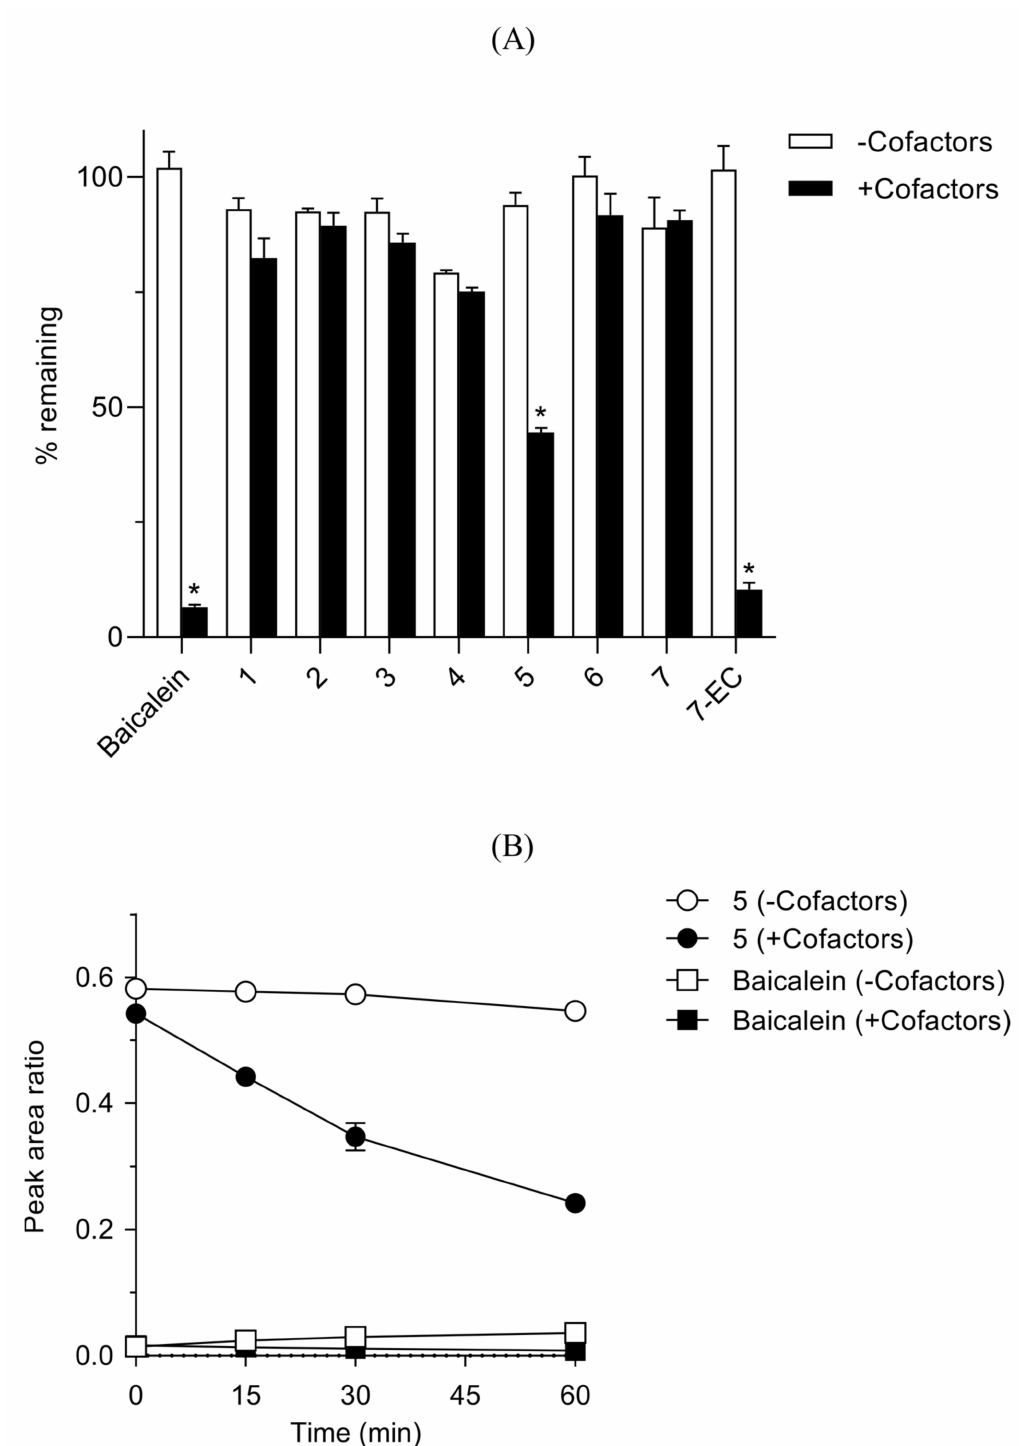
Figure 3. Metabolic stability of baicalein and its carbamate prodrugs in the mouse liver S9 fractions. Test compounds were incubated at 37 ◦ C with mouse liver S9 fractions in the absence and presence of the cofactor mixture (NADPH, UDPGA, PAPS and GSH). ( A ) % remaining was determined at 60 min vs. time 0 using peak ratios of LC − MS/MS chromatograms (mean ± SD, n = 3). * p < 0.001 (multiple unpaired t test). ( B ) Time course of compound 5 disappearance and its conversion to baicalein was determined simultaneously in the mouse liver S9 fractions following incubation of compound 5 in the absence and presence of the cofactor mixture (mean ± SD, n =